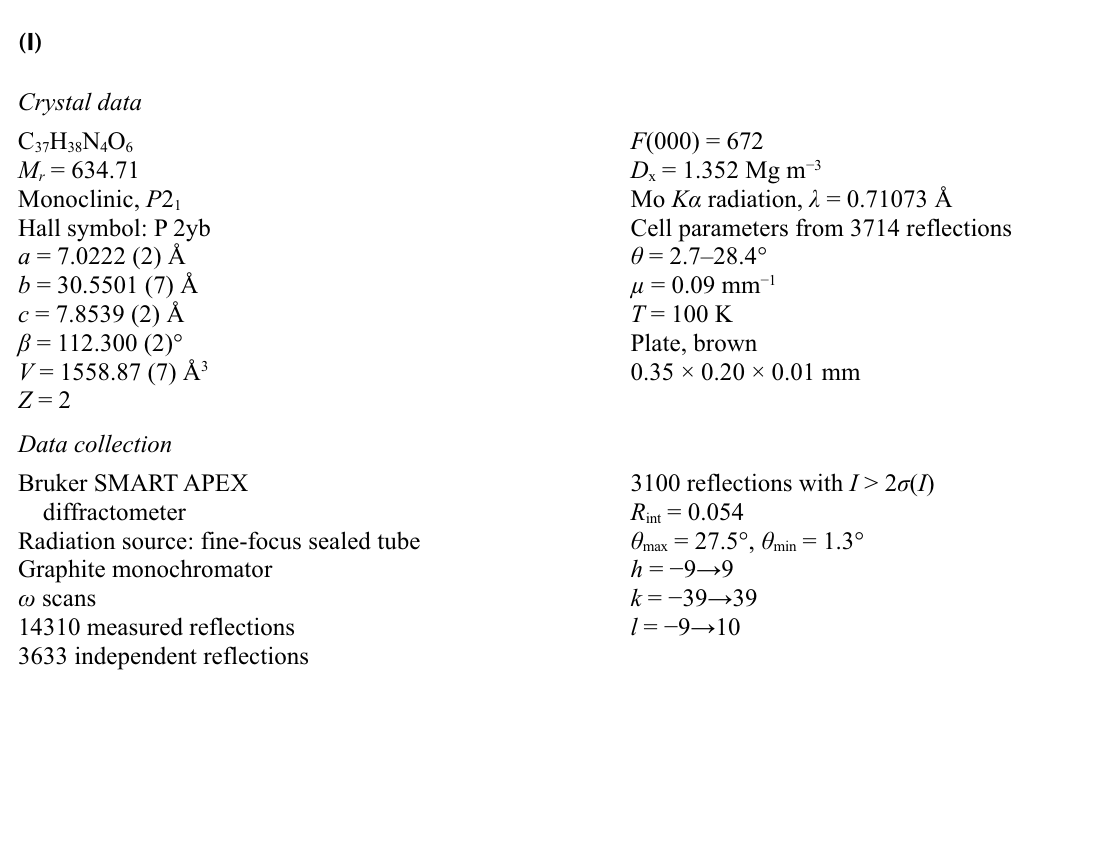
The molecular structure of the title compound showing the atomic numbering and 70% probability displacement